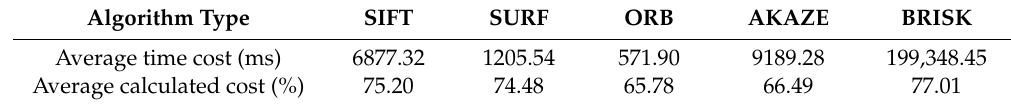
Table 1. Average time cost and average calculation cost of five types of operators.